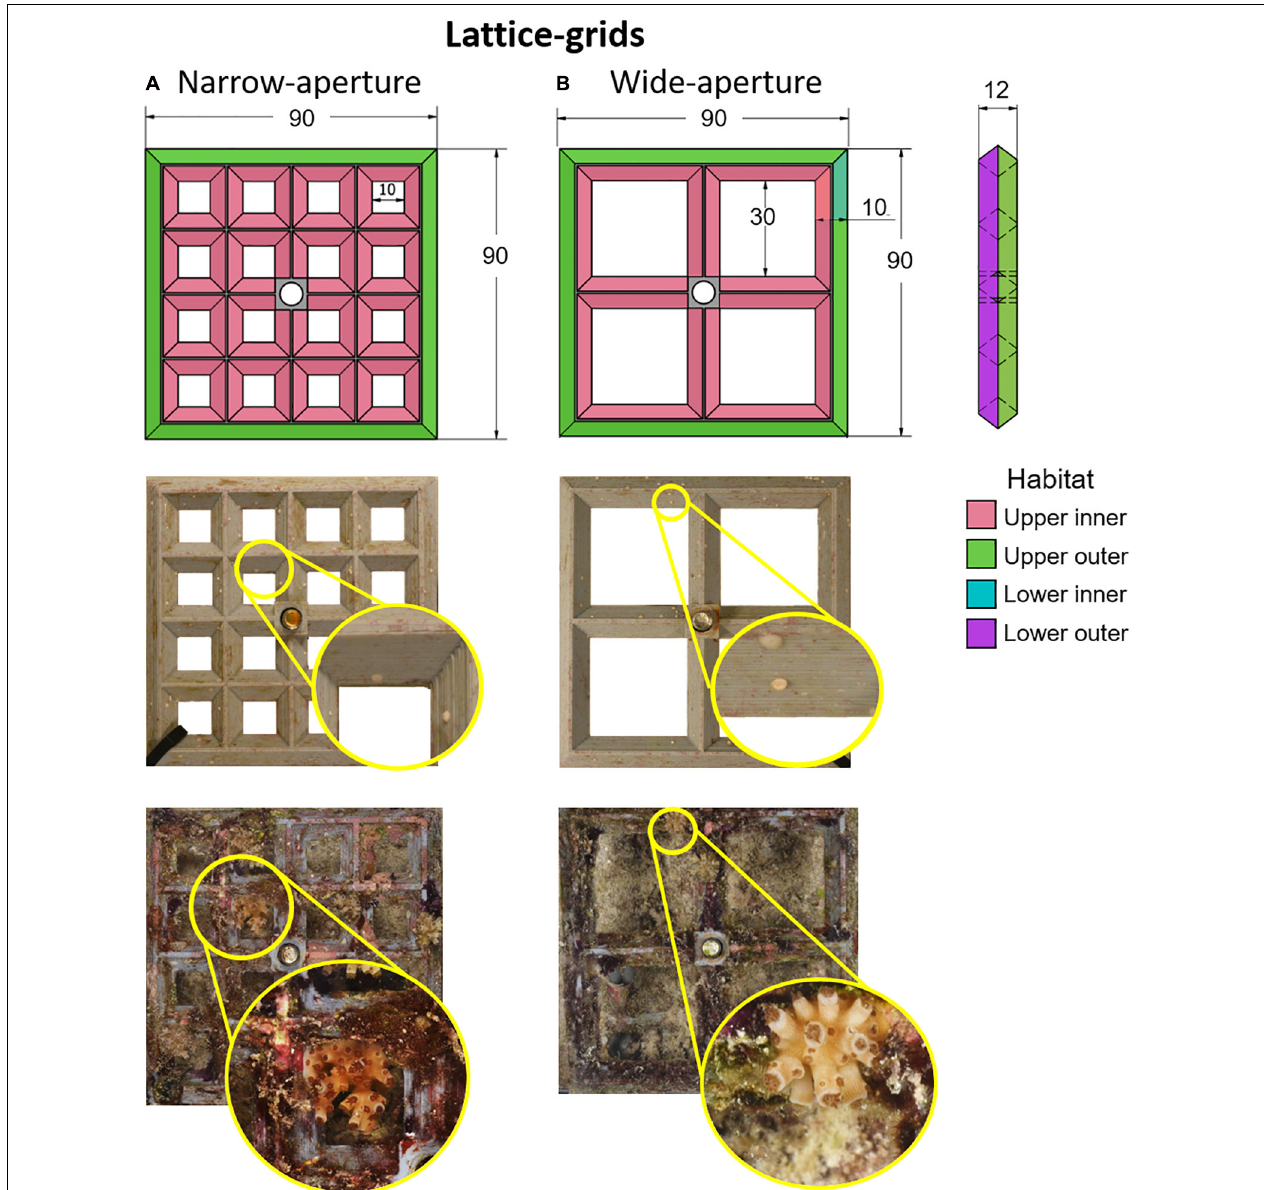
FIGURE 1 | Lattice-grids. Schematic diagrams (top row) with corresponding representative device images immediately after settlement (middle row) and after retrieval from a 1-year field deployment (bottom row) for two lattice-device types: narrow-aperture (A) and wide-aperture (B) . Colour shading in the first row indicates settlement habitats; note that only upper and outer surfaces are shown in this diagram. Insets for each image in the middle and bottom rows show close-ups of the Acropora tenuis spat or juvenile colonies, respectively, on each device type. Each image is of the underside of the device and shows the same corals as spat and juveniles. The brightness and contrast of inset images have been adjusted to improve the discrimination of coral spat and juveniles. In the top row, numbers indicate size in mm.